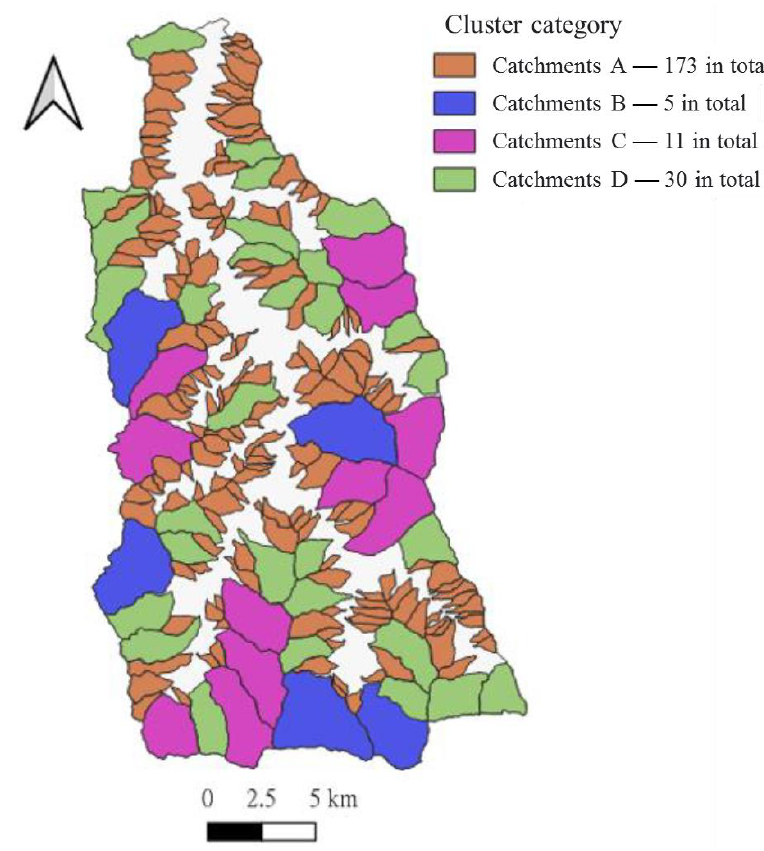
Figure 5. Distribution of clusters.